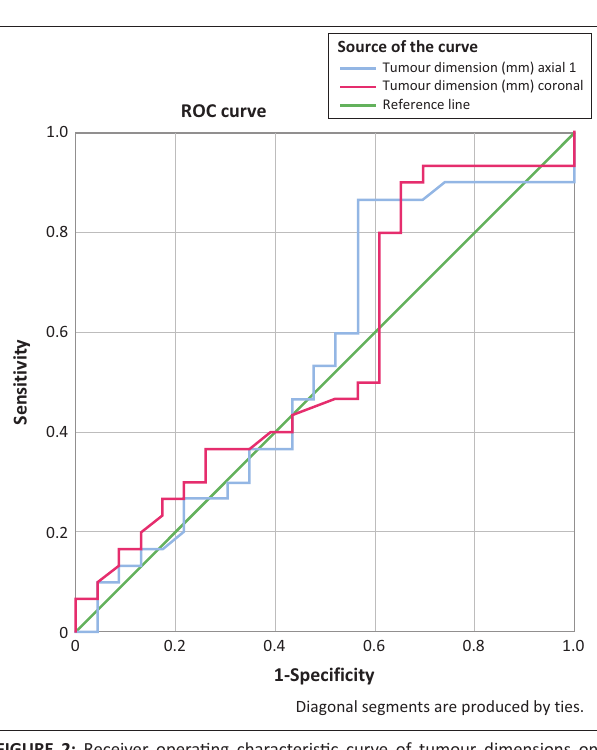
FIGURE 2: Receiver operating characteristic curve of tumour dimensions on coronal and axial magnetic resonance imaging. ROC, receiver operating